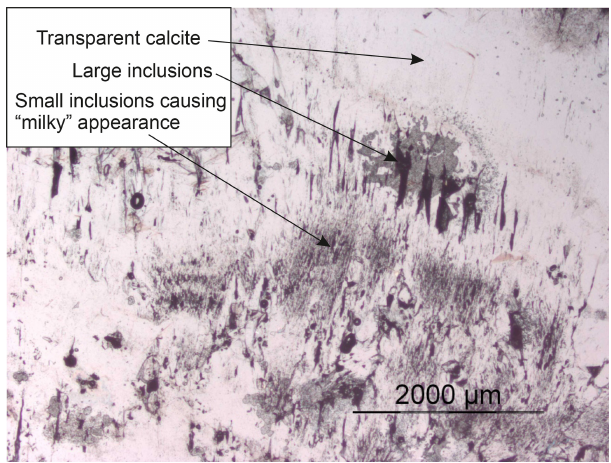
Figure 2. Macroscopic structure of SC-06-01 speleothem, showing alternation of transparent and milky fabrics.